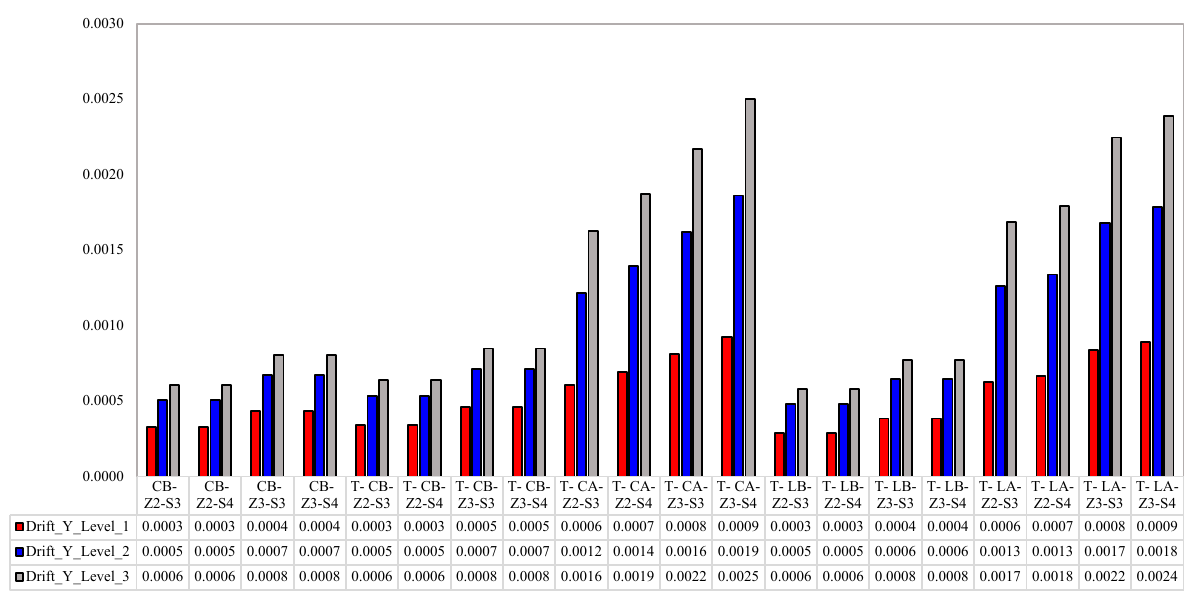
Figure 7. Drift by level in cross-aisle